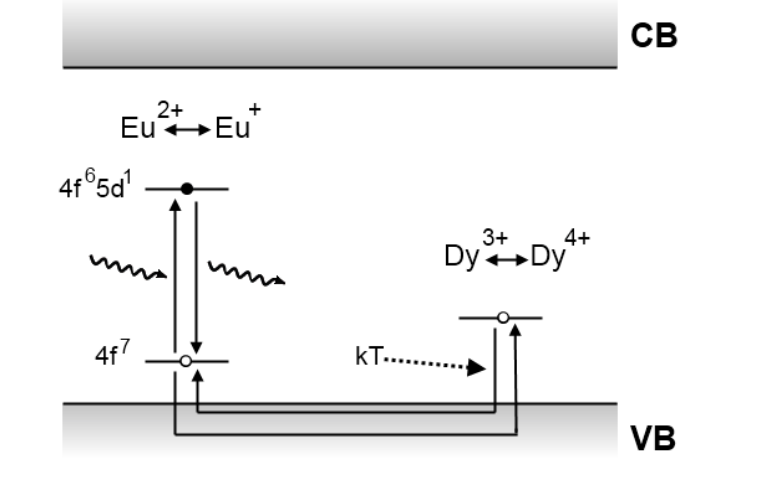
Figure 7. Persistent luminescence mechanism proposed by Matsuzawa et al . for SrAl O :Eu 2+ ,Dy 3+ 2 4